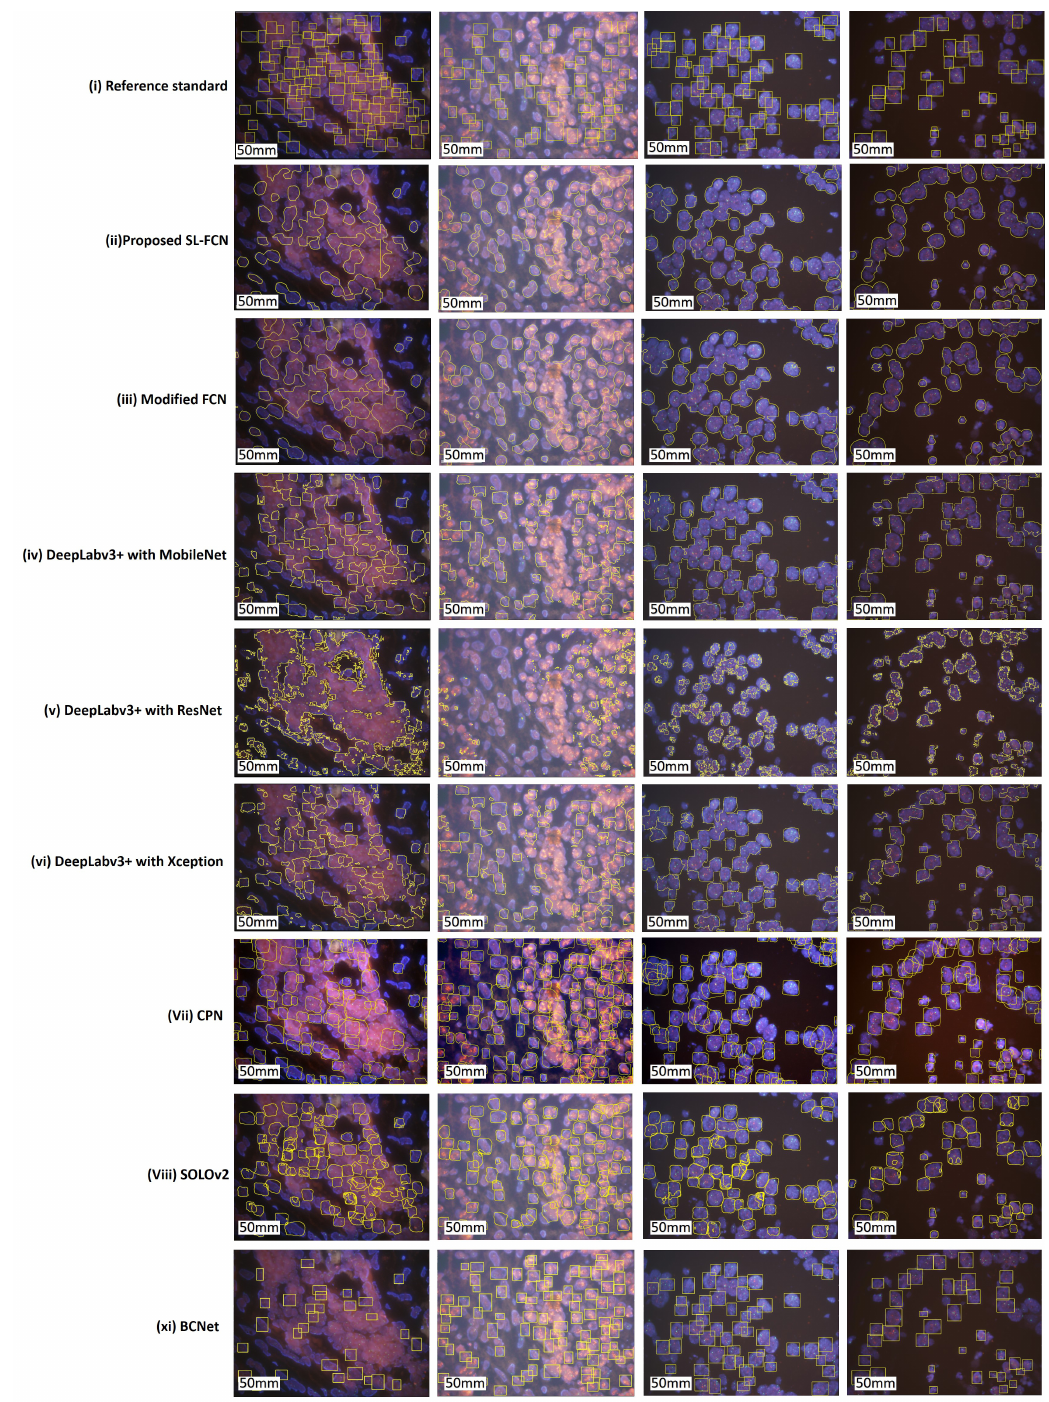
Figure 6. Qualitative segmentation results of the proposed SL-FCN method and the baseline methods for segmentation of HER2 amplification in the FISH